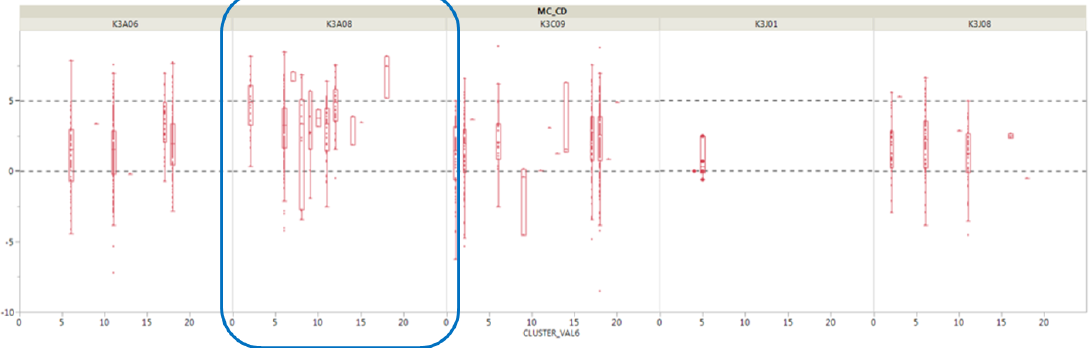
Figure 7. Box plot from the clusters of the specific vulcanizer.